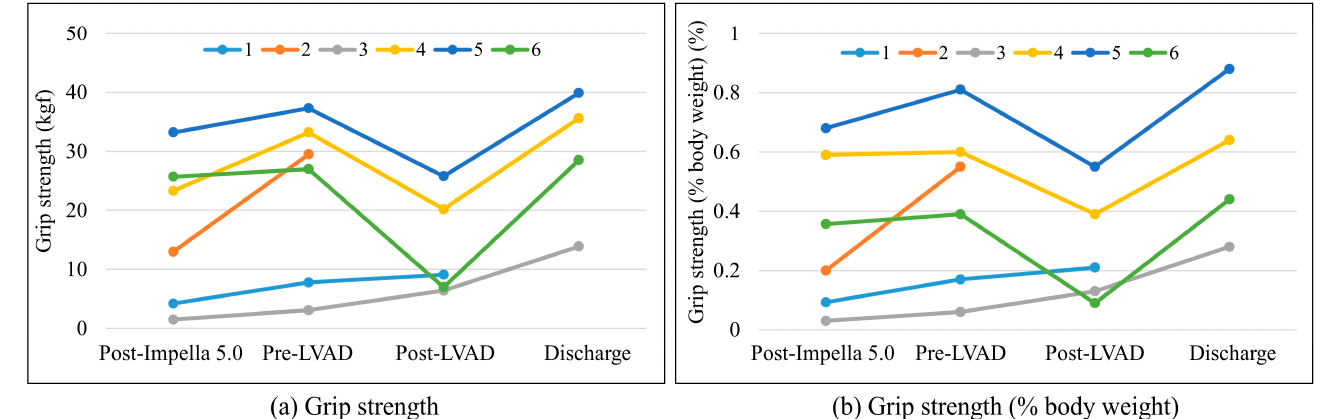
Figure 1. Change in ( a ) grip strength and ( b ) grip strength (% body weight). Adverse events during CR included loss of consciousness in one patient. While sitting in a wheelchair and taking physical measurements after removing the elastic bandage attached to the lower leg, flow decreased and the waveform of Impella flattened, resulting in hypotension and loss of consciousness. When the patient was placed in bed, they quickly regained consciousness, and there was no Impella malposition. No other adverse events were observed during CR, and the patient was able to practice walking.